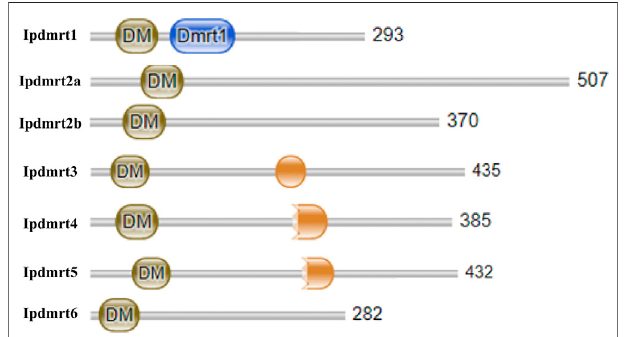
FIGURE 1 | Schematic diagram of the construction of seven IpDmrt proteins. Image (a) shows the schematic diagram of seven IpDmrt protein domains; all the identi fi ed proteins present a conserved DM domain, and IpDmrt1 has an additional DMRT-1